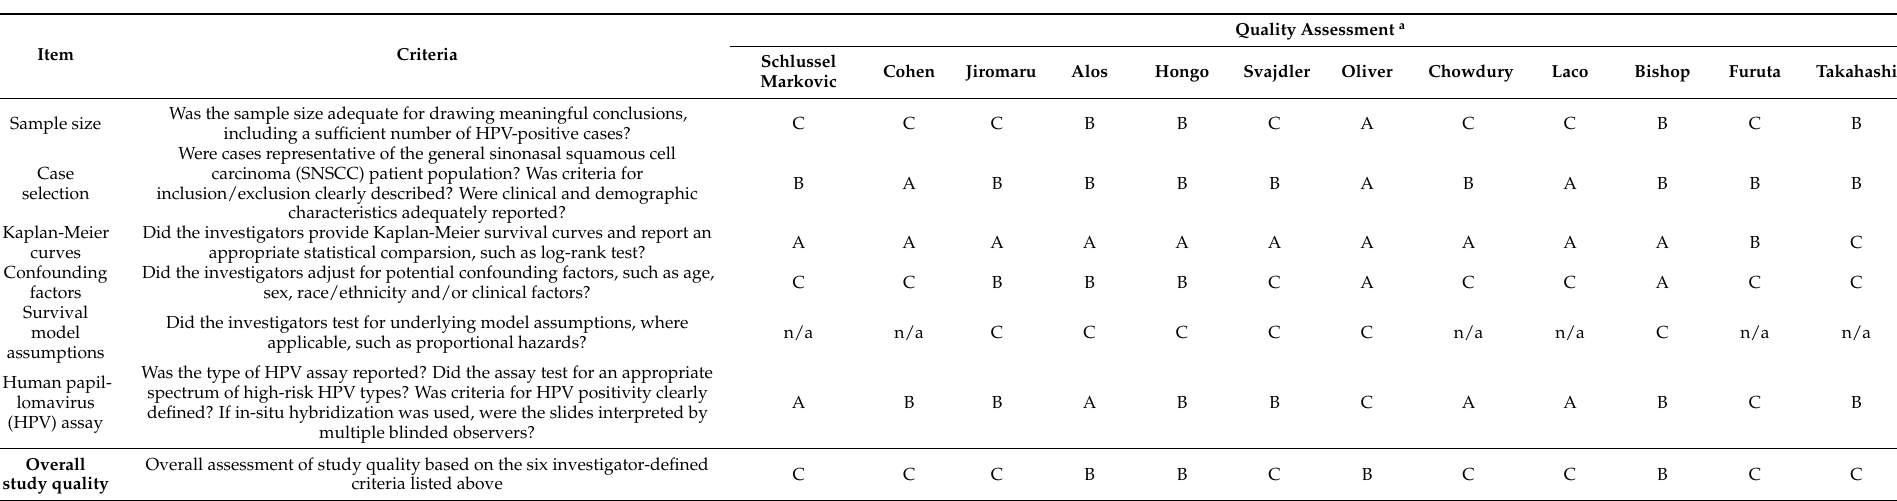
Table 2. Qualitative assessment of quality and potential risk of bias for the studies included in the